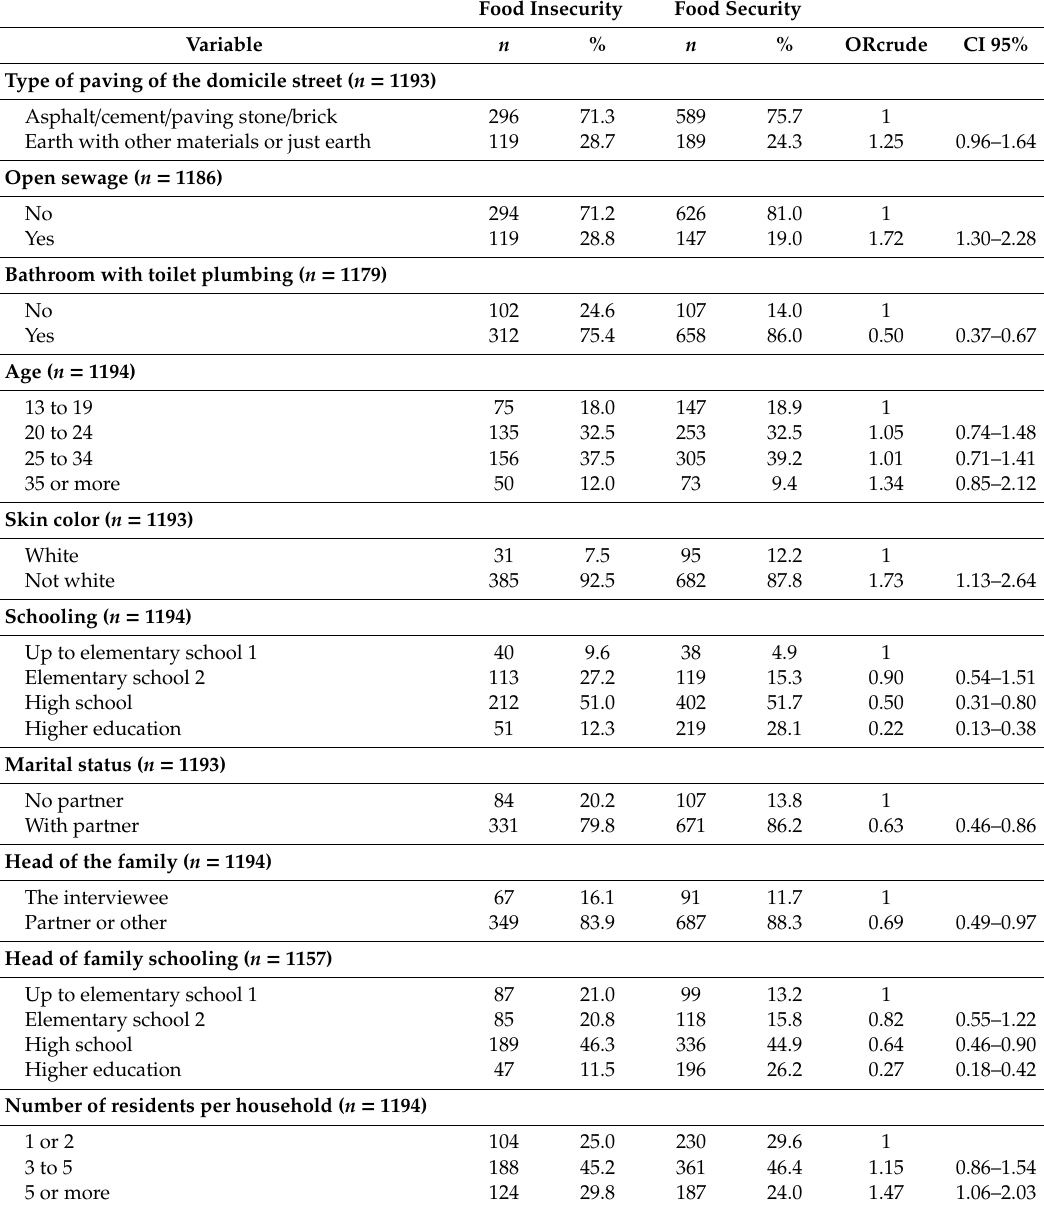
Table 2. Food insecurity during gestation according to socioeconomic and demographic characteristics. Rio Branco, Acre,